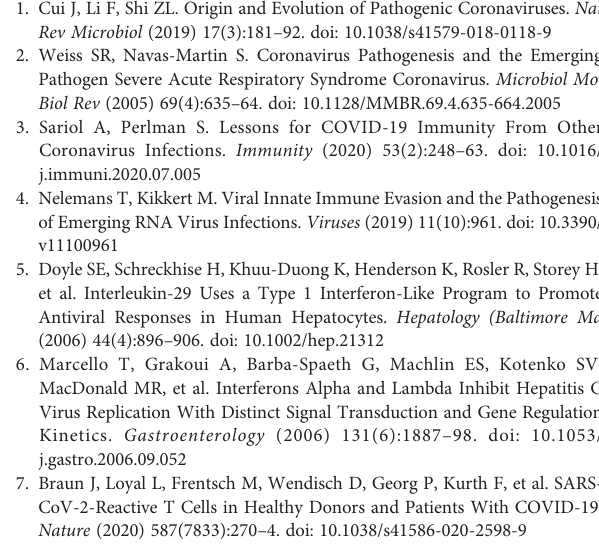
Supplementary Figure 9 | KEGG map colored with pathview (117) “ T cell receptor signaling pathway ” (hsa04660). Signi fi cantly DEGs (adj. P-Value < 0.01) are colored based on their log2 fold change. Left panel: boxes are separated into 3 slots, for OXY0 versus INFL, OXY1 versus INFL and TUBE-early versus INFL. Right panel: boxes are separated into 2 slots, for INFL versus HTLY and TUBE_early versus HLTY. Supplementary Figure 10 | KEGG map colored with pathview (117) “ Th1 and Th2 differentiation ” (hsa04658). Signi fi cantly DEGs (adj. P-Value < 0.01) are colored based on their log2 fold change. Upper panel: boxes are separated into 3 slots, for OXY0 versus INFL, OXY1 versus INFL and TUBE-early versus INFL. Lower panel: boxes are separated into 2 slots, for INFL versus HTLY and TUBE_early versus HLTY. Supplementary Figure 11 | KEGG map colored with pathview (117) “ Th17 differentiation ” (hsa04659). Signi fi cantly DEGs (adj. P-Value < 0.01) are colored based on their log2 fold change. Upper panel: boxes are separated into 3 slots, for OXY0 versus INFL, OXY1 versus INFL and TUBE-early versus INFL. Lower panel: boxes are separated into 2 slots, for INFL versus HTLY and TUBE_early versus HLTY. Supplementary Figure 12 | KEGG map colored with pathview (117) "B cell receptor signaling pathway" (hsa04662). Signi fi cantly DEGs (adj. P-Value < 0.01) are colored based on their log2 fold change. Upper panel: boxes are separated into 3 slots, for OXY0 versus INFL, OXY1 versus INFL and TUBE-early versus INFL. Lower panel: boxes are separated into 2 slots, for INFL versus HTLY and TUBE_early versus HLTY. Supplementary Figure 13 | Box plots for selected genes involved in B cells functions/maturation/regulation. Supplementary Figure 14 | KEGG map colored with pathview (117) "Complement and coagulation cascades" (hsa04659). Signi fi cantly DEGs (adj. P- Value < 0.01) are colored based on their log2 fold change. Left panel: boxes are separated into 3 slots, for OXY0 versus INFL, OXY1 versus INFL and TUBE-early versus INFL. Right panel: boxes are separated into 2 slots, for INFL versus HTLY and TUBE_early versus HLTY. Supplementary Figure 15 | Boxplots plots for complement, coagulation and blood